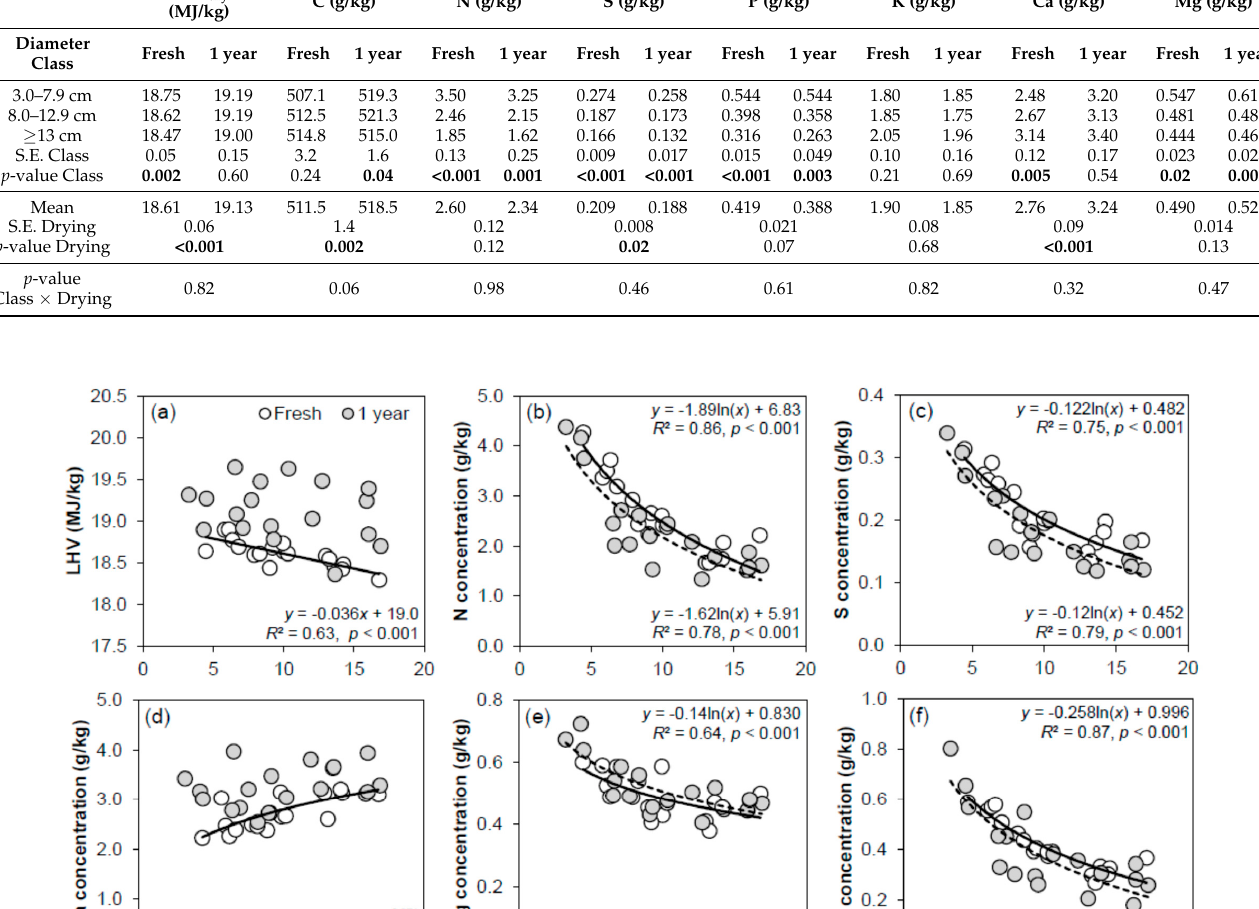
Table 3. Diameter and chemical properties ( ± S.E. of the mean) of unsplit firewood logs (110 cm in length). Means not connected with the same letter are significantly different ( α = 0.05, Tukey’s HSD test). n = 12 for hybrid poplar and n = 6 for the other species. p -values in bold denote a significant